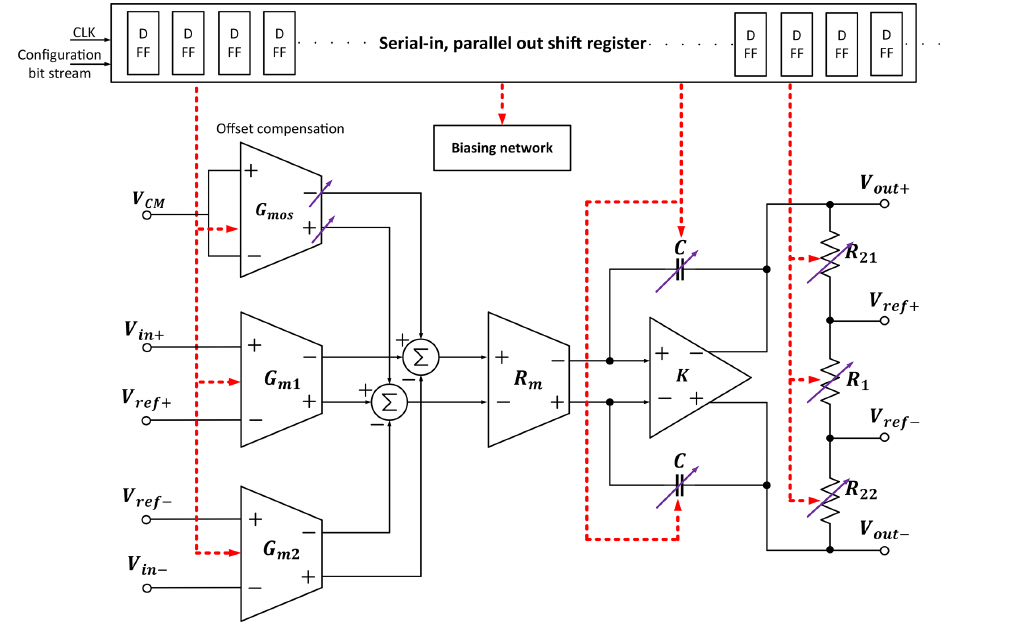
Figure 1. The block diagram of the reconfigurable current-feedback instrumentation amplifier